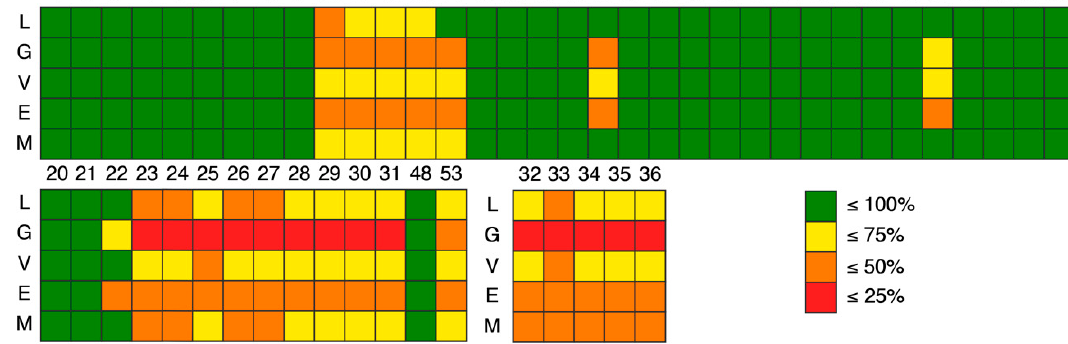
Figure 8. Colormap of the compliance with rules of drug-likeness: L—Lipinski, G—Ghose, V—Veber,